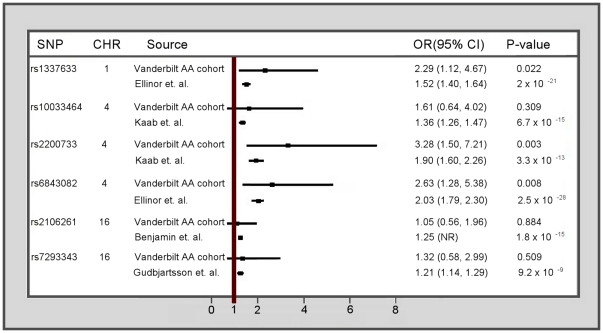
A comparison of previously identified significant SNPs from literature to African Americans from Vanderbilt AF cohort.The case/control sample size for the previously published studies are: Ellinor et. al n = 14,179 (11); Kaab et. al. n = 36,196 (9); Benjamin et. al. n = 46,736 (10); and Gudbjartsson et al. n = 39,014 (50). AA =  Subjects with self-reported African American race.